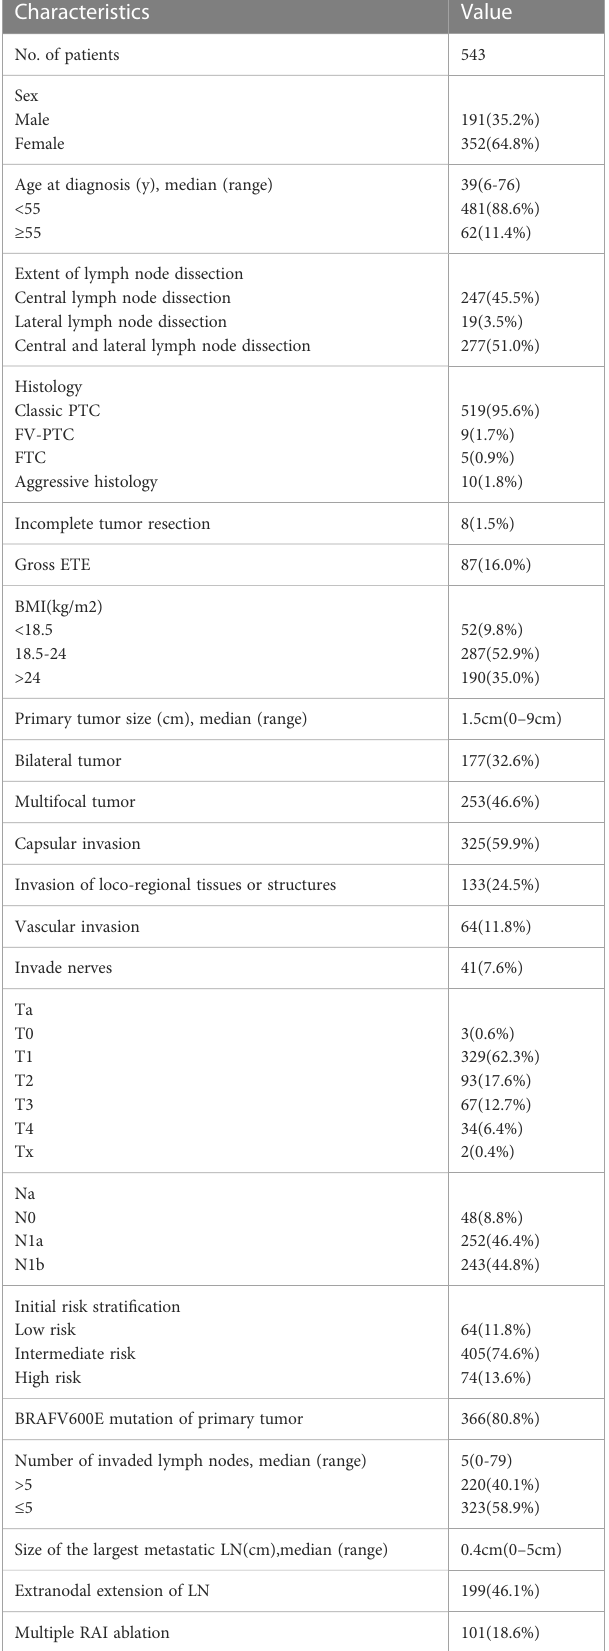
The median value of the size of LNM was 0.4 cm (range, 0 – 5.0 cm), with a median value of 0.3 cm in patients with long-term remission and 1.1 cm in patients with poor prognosis (P < 0.001) (Figure 2). The median of time interval among fi rst operation and initial RAI ablation was 2.0 months (range, 0 – 103 months). The optimum cut-off value for the size of LNM was decided using the X-tile software (version 3.6.1, Yale University), and the result is shown in Figure 3A. All patients were divided into 3 risk strati fi cation for the assessment of long-term remission. There were 282 patients with the size of LNM ≤ 0.4 cm (low-risk group), 199 patients with the size of LNM ranging from 0.4 cm to 1.4 cm (intermediate-risk group), and 62 patients with the size of LNM > 1.4 cm (high-risk group) (Figure 3B). Curves of DFS were shown in the Kaplan-Meier method, the low-risk group had 92.2% DFS rates, intermediate-risk group had 67.3% DFS rates, high-risk group had 32.3% DFS rates. The hazard ratio (95% CI) of the high-risk patients